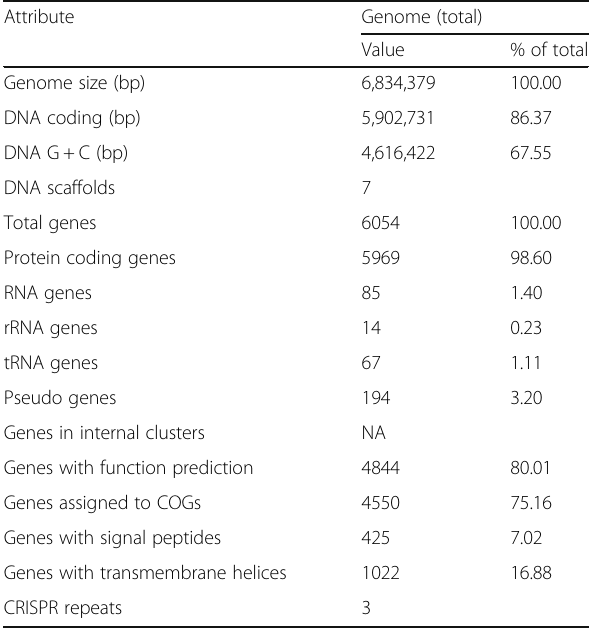
Table 4 Genome statistics of A. humicireducens SgZ-5 T